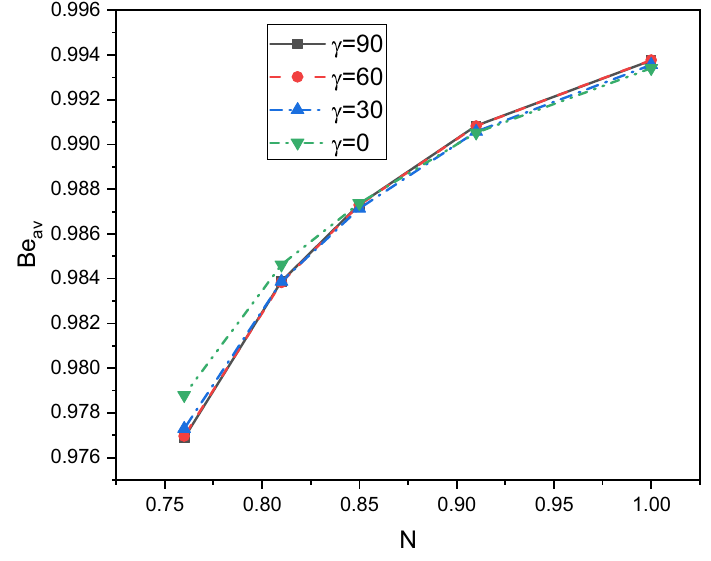
Figure 6. Impacts of the power-law index N and inclination angle γ on the average Bejan number at Ra = 10 5 , Da = 10 − 3 , b = 0.6, d = 0.5, Ma = 1000, β = 0.95, τ = 1, φ = 2%, Rd = 1, � = 10 − 4 .